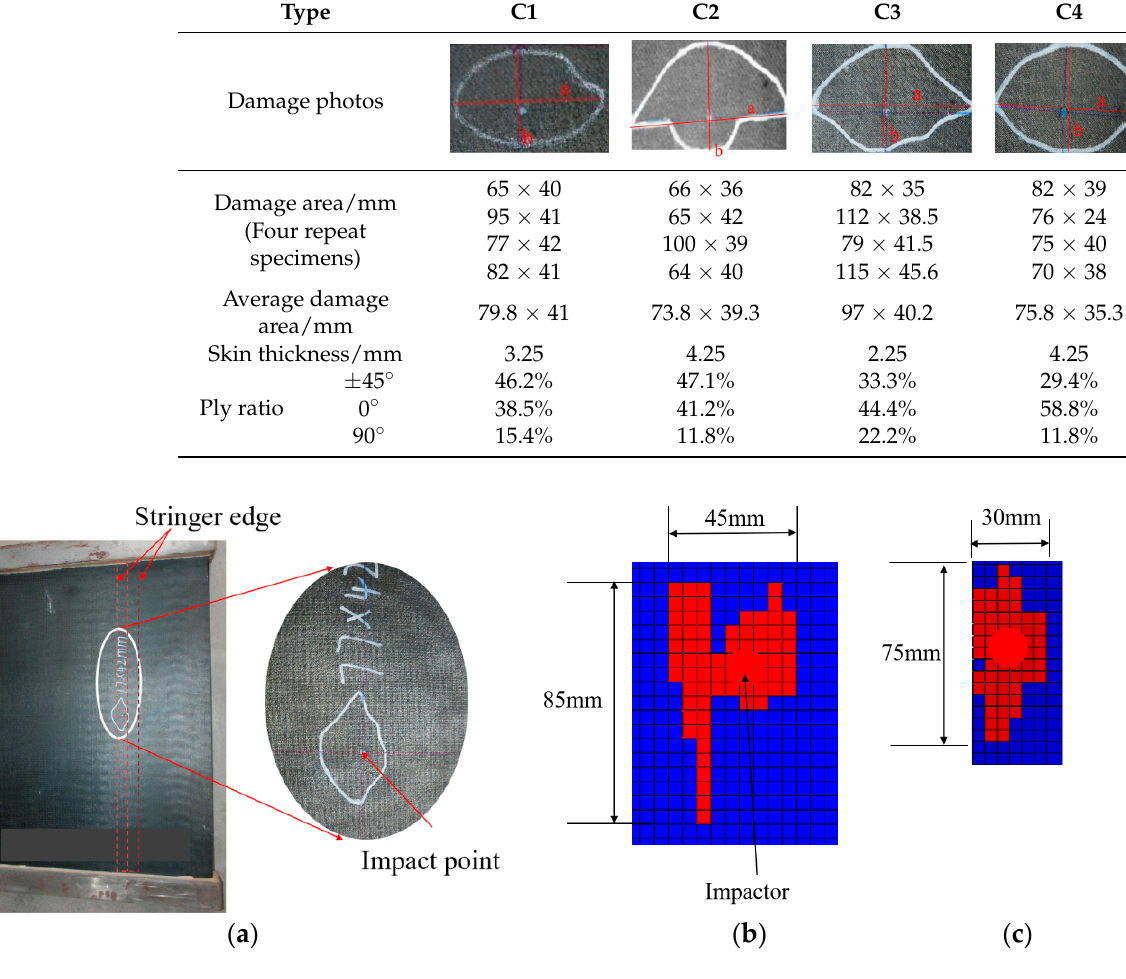
Figure 7. Impact position and shape: ( a ) Impact position and shape, ( b ) Damage on the skin, ( c ) Damage on the stringer.